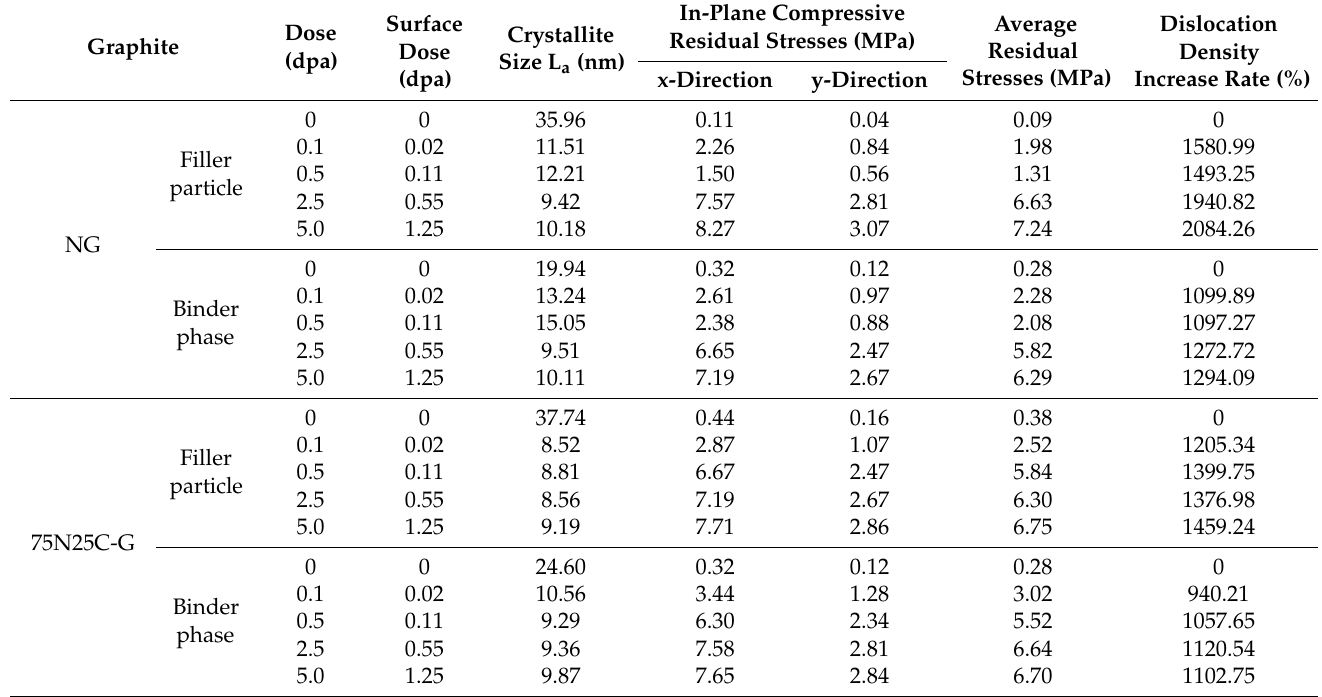
Table 2. Structural characteristics of virgin and irradiated NG and75NG25C-G graphite determined using Raman spectral